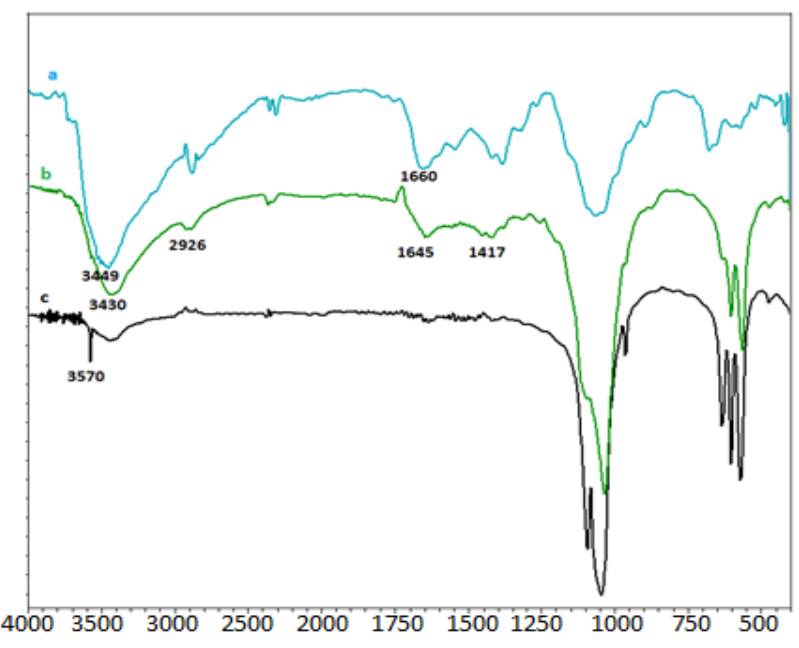
Figure 1. FT-IR of, ( a ): chitosan; ( b ): HAp/CTs; and ( c ): HAp. The absorption bands of the PO 43 − ions that comprise the apatitic network are dis- tinguished by two absorption domains (the 1100–900 cm − 1 domain and the 600–500 cm − 1 domain, respectively). The hydroxyl ion of hydroxyapatite is responsible for the absorp- tion band at 3570 cm − 1 [17]. The NH 2 and OH groups of chitosan are responsible for the broadband at 3449 cm − 1 . The hydroxyapatite/chitosan compound shifts this band to 3566 cm − 1 [19]. The vibrations of N-H and O-H of chitosan are represented by the bandwidth between 3100 and 3500 cm − 1 [42]. The C-H stretch vibration of the methylene groups is responsible for the band at 2926 cm − 1 . The deformation vibration of N-H of the NH 2 groups is represented by the band at 1588 cm − 1 [2]. The C-OH and C-N groups’ stretching vibrations correspond to absorption bands at 1076 and 1379 cm − 1 ,